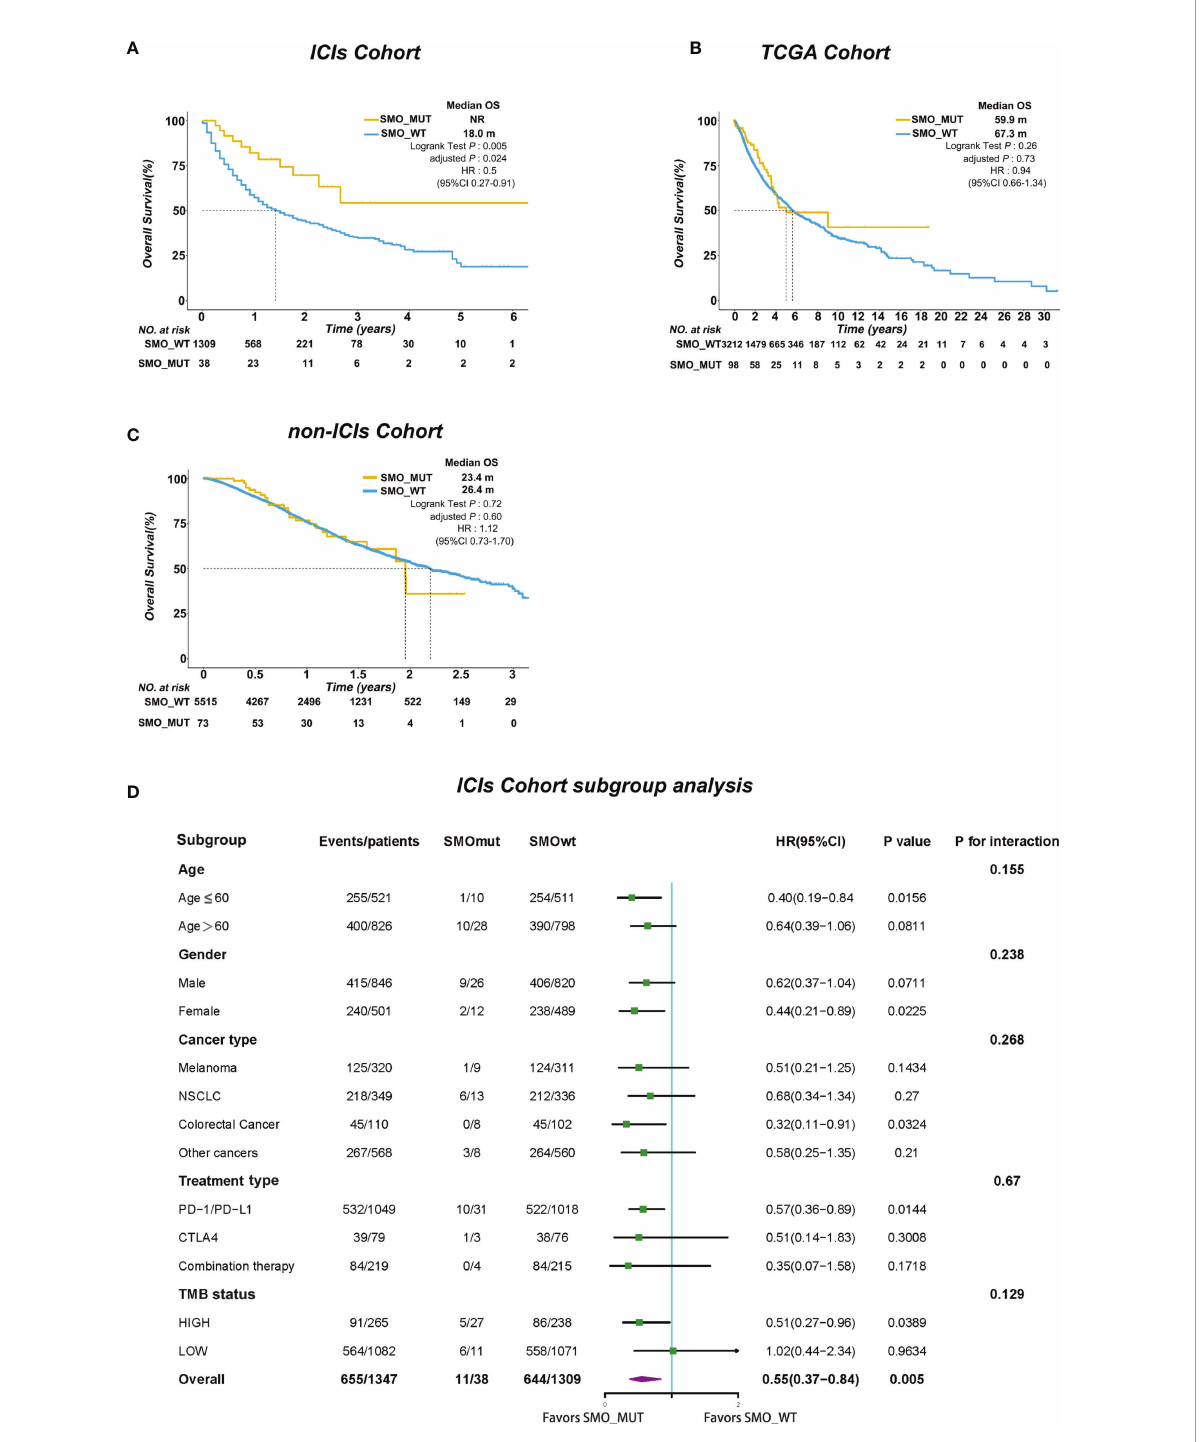
FIGURE 2 SMO mutation predicted survival advantage in the pan-cancer cohort. (A – C) Kaplan – Meier curves comparing the overall survival (OS) between SMO mutant (SMO_MUT) and SMO wild-type (SMO_WT) patients in the immune checkpoint inhibitor (ICI) cohort (Samstein et al.), The Cancer Genome Atlas (TCGA) cohort, and the non-ICI cohort (Zehir et al.; log-rank test). (D) Forest plot depicting the results of the subgroup analysis in the ICI